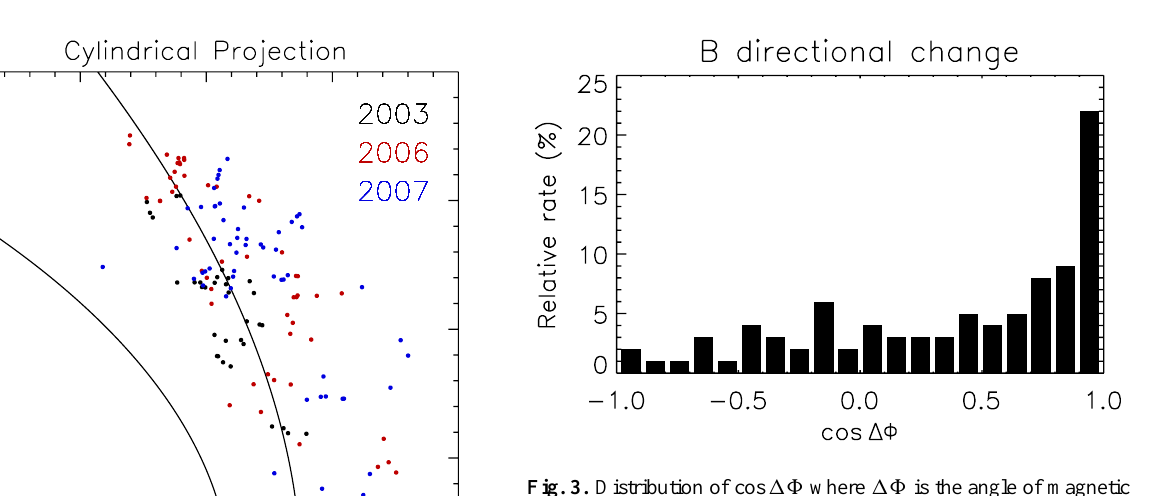
Fig. 3. Distribution of cos 18 where 18 is the angle of magnetic field directional change at the